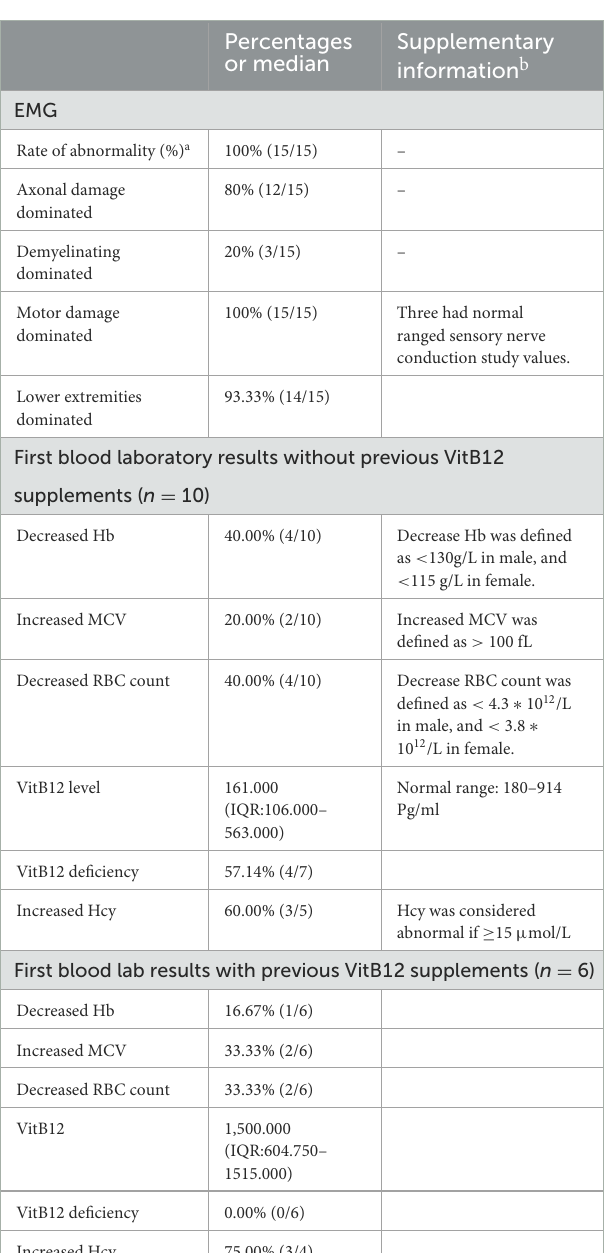
TABLE 3 Electromyography (EMG) and lab findings of the patients.